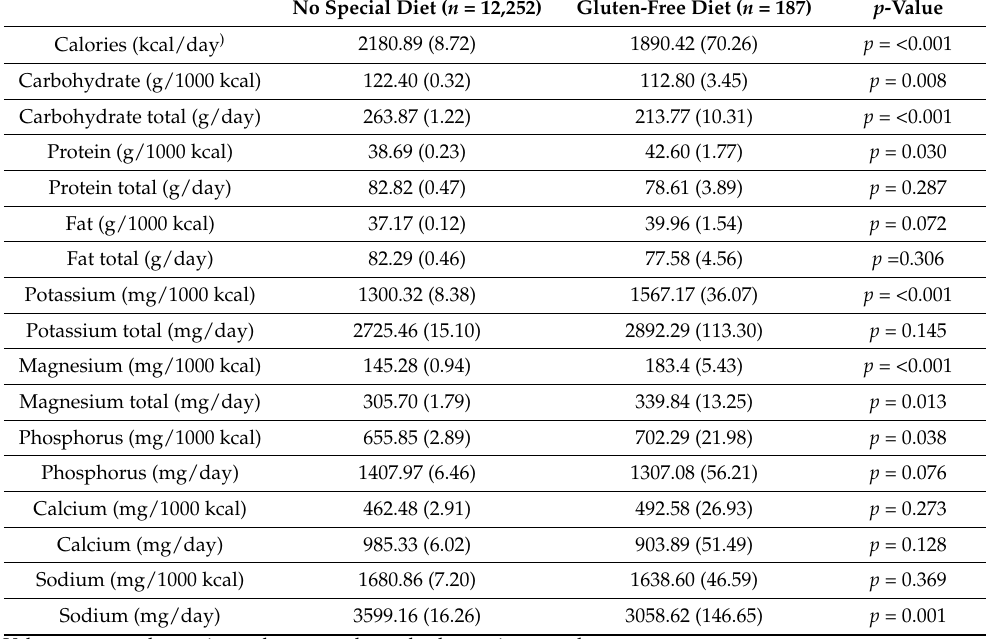
Table 3. Sample characteristics: energy, macro- and micronutrient intake.